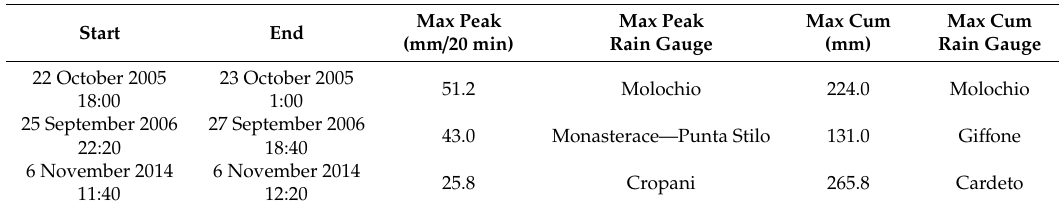
Table 3. Tropical-Like Cyclones (TLC)